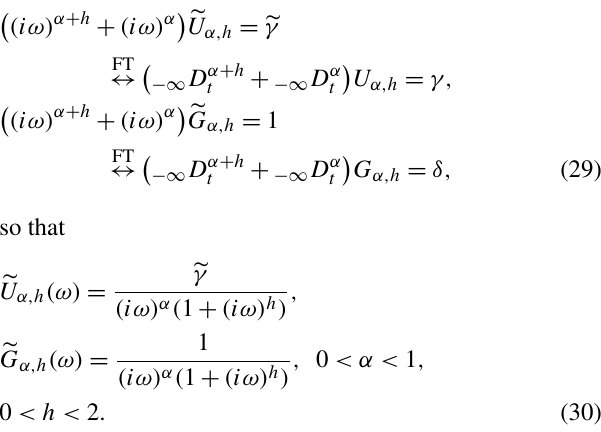
Figure 2. The storage Green functions for the fractional relaxation equation ( α = 0): (a) impulse response ( G h,h ); (b) step response ( G 1 + h,h ). Black is for h = 1 / 10, 2 / 10, ... 10 / 10 and red for 11 / 10, 12 / 10, ... 19 / 10 (to identify the curves; use the fact that at large t , they are in order of increasing h – bottom to top). For small t , G h,h ∝ t 2 h − 1 (Eq. 15), so that for h ≤ 1 / 2, the impulse response is singular at the origin. For large t , G h,h ∝ t h − 1 (Eq. 18), so that for h < 1, the total impulse response storage decreases following the impulse; for h = 1 (the EBE), it tends to unity, and for h > 1, it